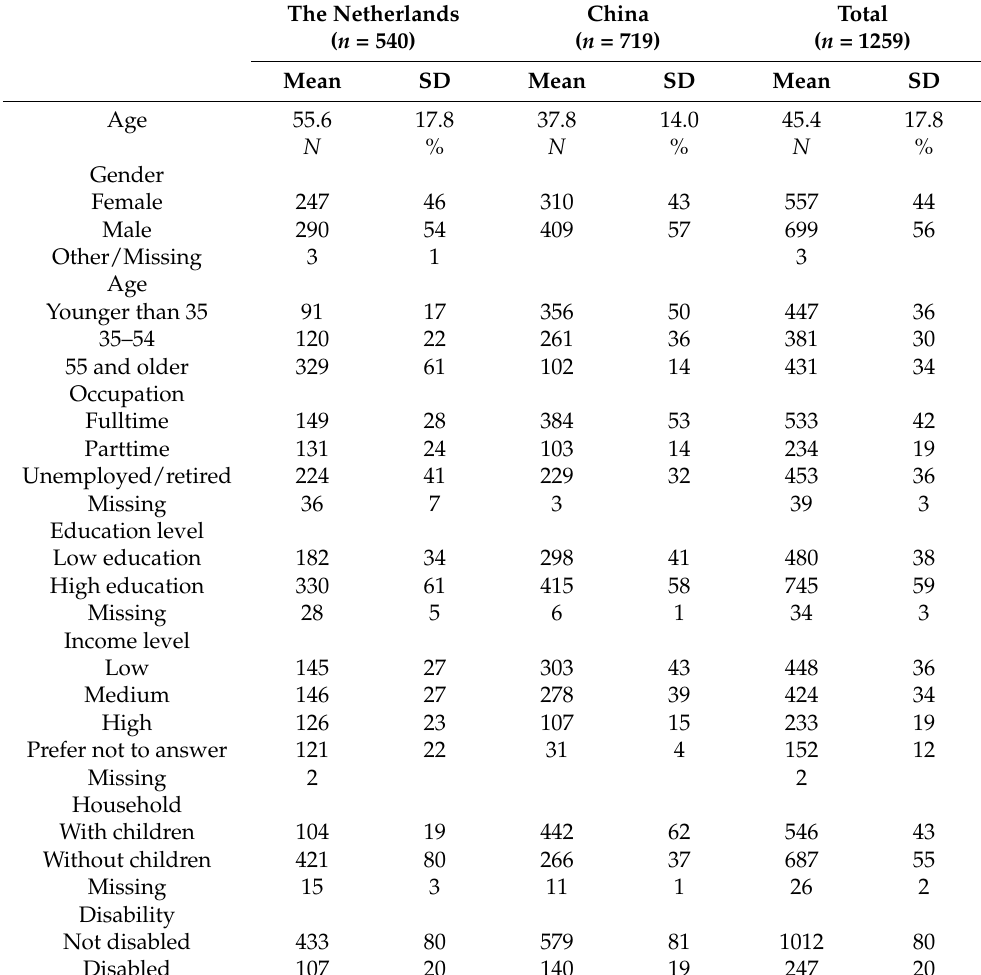
Table 4. Sample characteristics of the